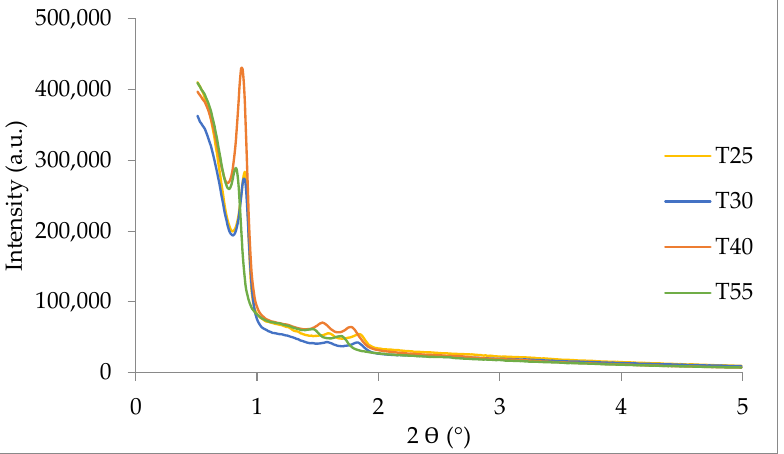
Figure 2. Low angle X-ray diffraction patterns of samples for the study of the influence of temper- ature.